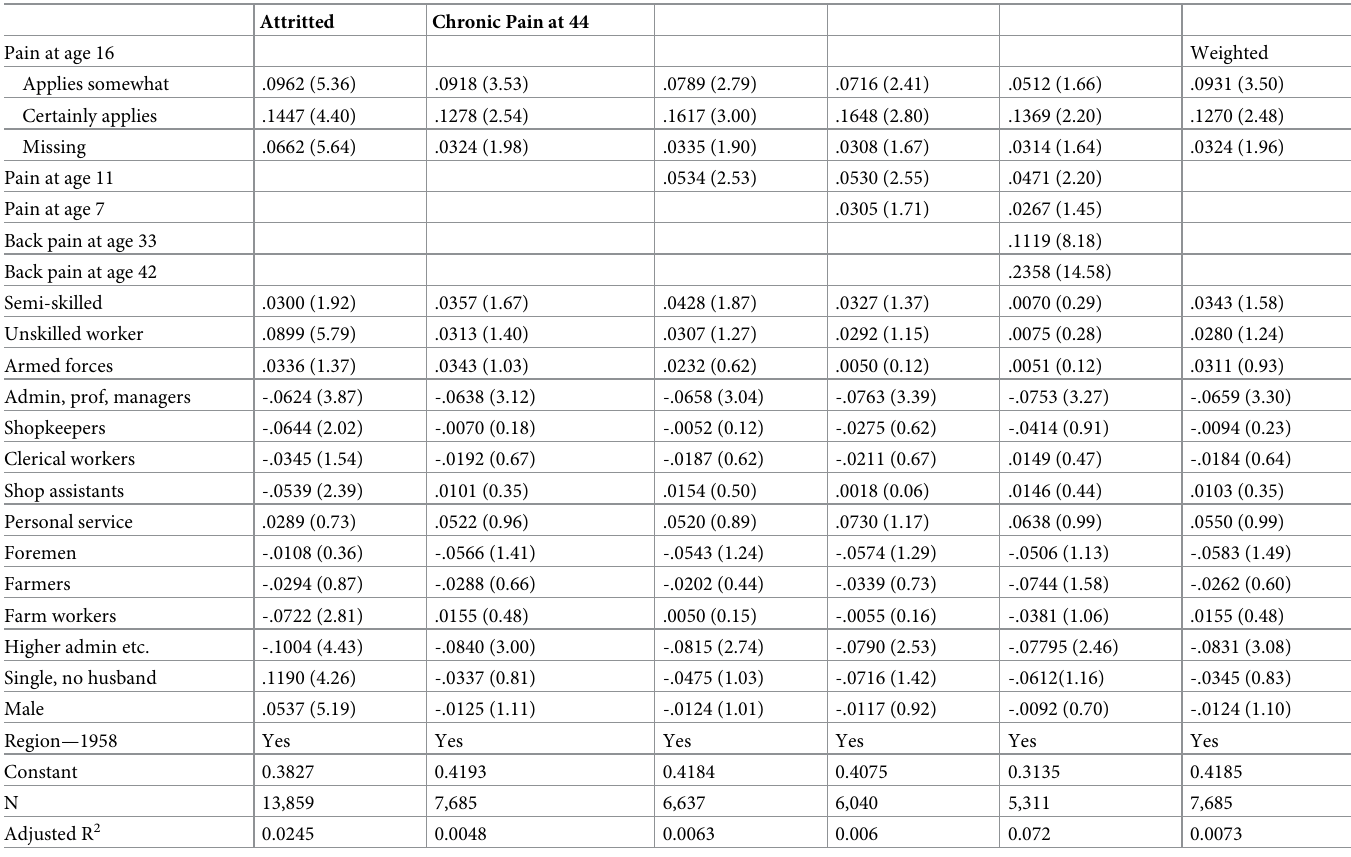
Table 6. Attrition and Chronic Pain in the BMS (OLS), 1958–2004.